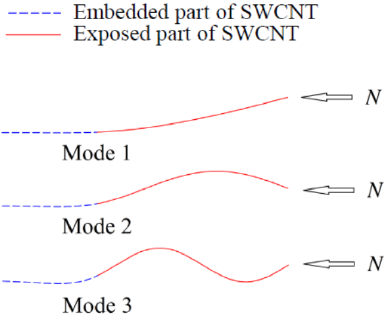
Figure 8. The first three vibrational modes of the partial embedded carbon nanotubes resonator under an external compressive force [92].